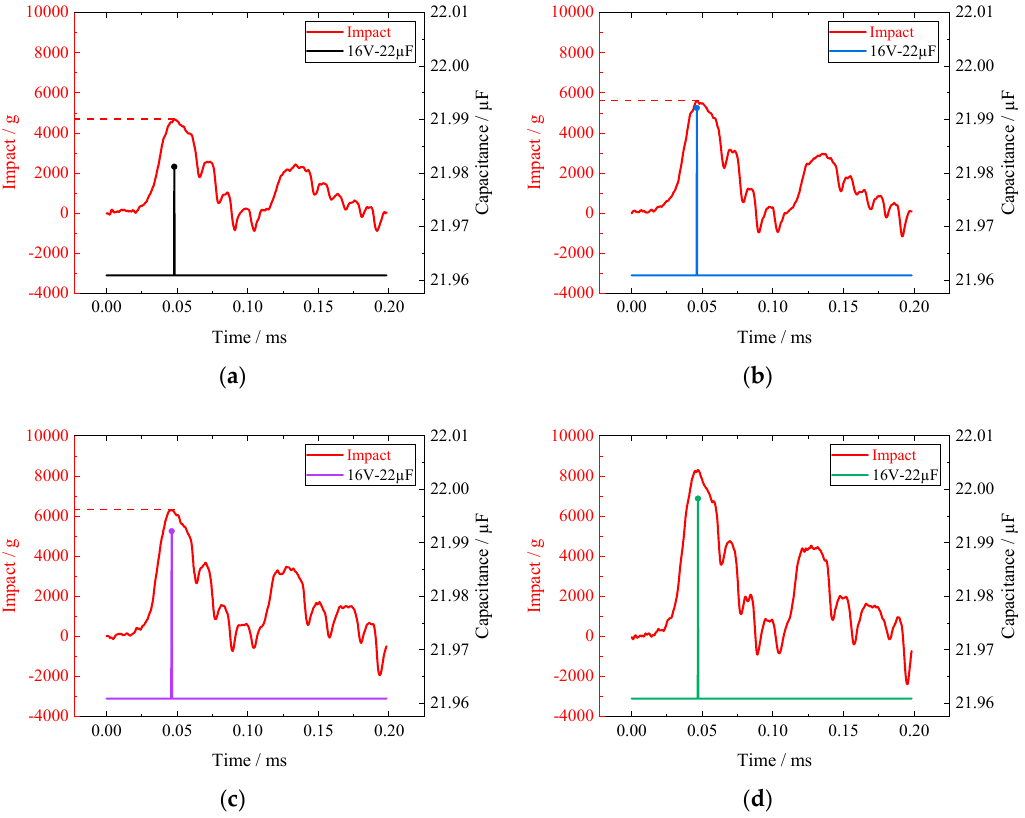
Figure 3. Change in ceramic capacitance with impact acceleration. ( a ) The impact peak value is 5209 g. ( b ) The impact peak value is 5608 g. ( c ) The impact peak value is 6305 g. ( d ) The impact peak value is 8297 g. Table 2. Capacity change of the MLCC under a di ff erent impact